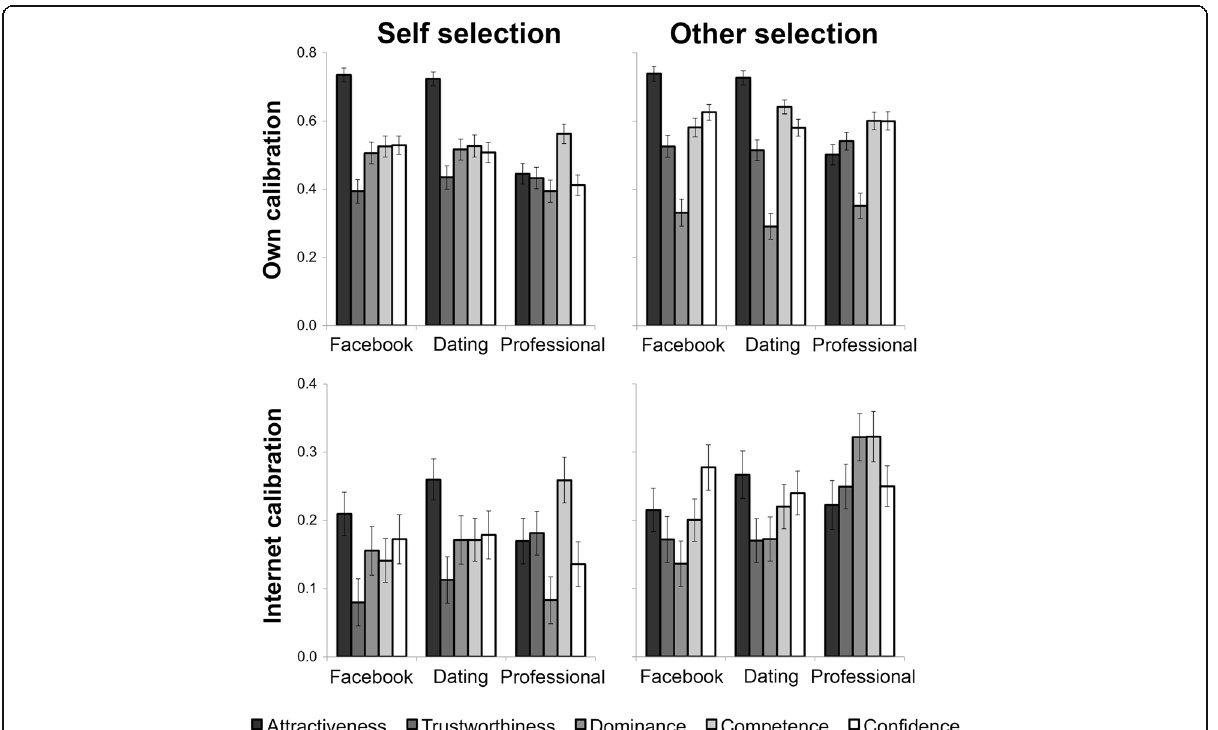
Fig. 2 Results from the Calibration experiment. Calibration was computed separately for self-selection and other-selection as the correlation between likelihood of profile image choice and: (1) participants ’ own trait impressions ( top panels ); (2) impressions of unfamiliar viewers recruited via the Internet ( bottom panels ). Higher calibration indexes participants ’ ability to choose profile images that increase positive impressions. Participants ’ likelihood of selecting a photograph of their own face (self-selection: top left ) and an unfamiliar face (other-selection: top right ) was strongly calibrated to their own impressions. However, in general, self-selections were less well calibrated to the impressions of unfamiliar viewers ( bottom left ) than were other-selections ( bottom right ). Error bars represent ±1 standard